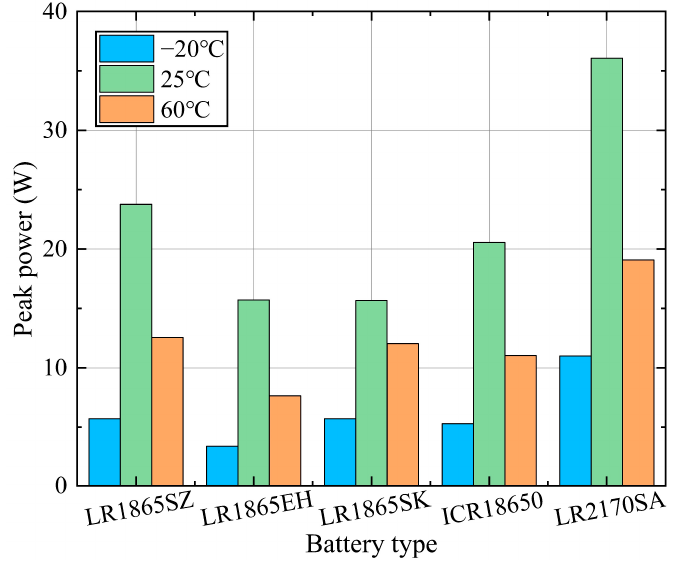
Figure 2. Peak power of different types of batteries (LR1865SZ, LR1865EH, LR1865SK, ICR18650, and LR2170SA) under various temperatures ( − 20, 25 and 60 °C).